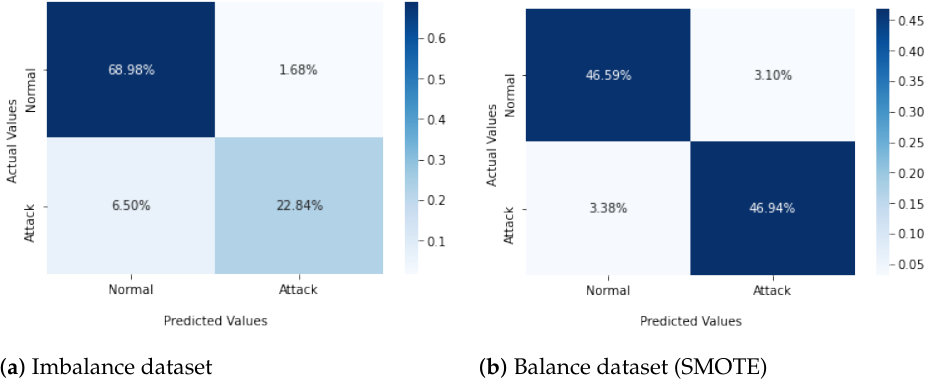
Figure 11. Confusion matrix for best model (RF) on imbalance and SMOTE balanced power Figure 10. Confusion matrix for best model (RF) on imbalance and SMOTE balanced power sys- system dataset tem Table 9: Comparison with previous works on FDIA detection for power system dataset